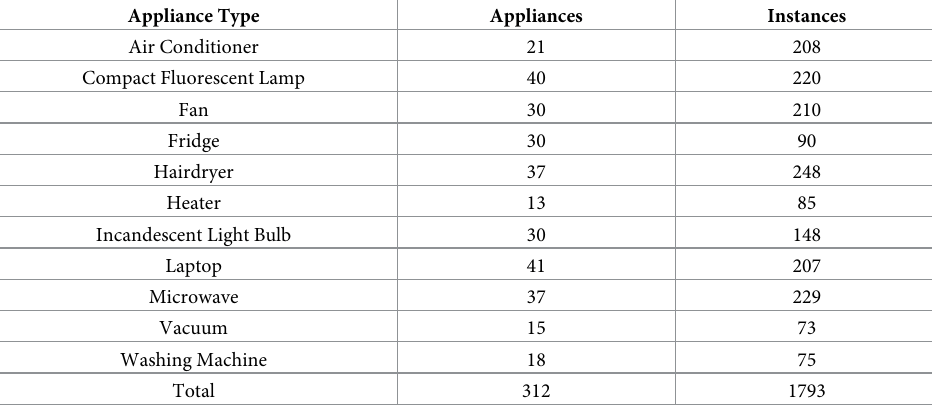
Table 1. The PLIAD dataset of appliance types and instance